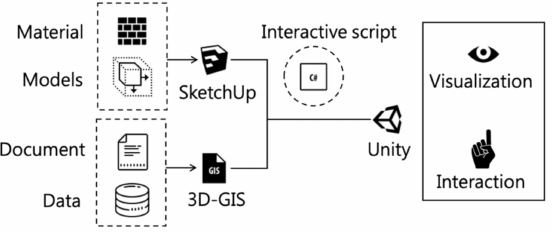
Figure 8. Optimizing virtual environment with interactive script.